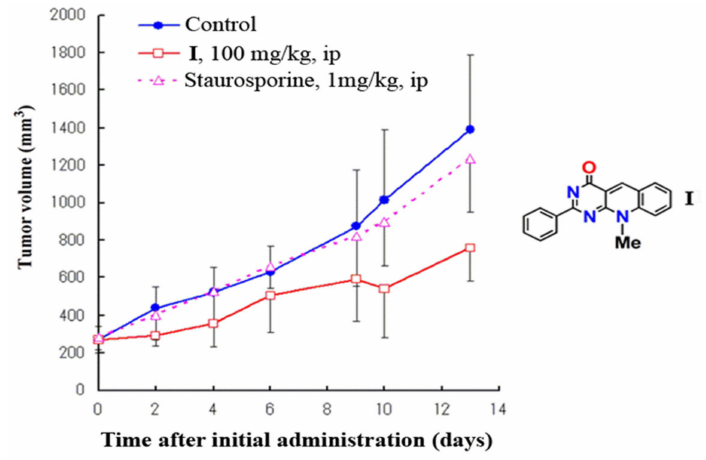
Figure 1. One hundred mg / kg, i.p., of compound I reduced the tumor volume of Subcutaneous (SC) implanted A431 into nude mouse 53.4% after 10 days of 100 mg / kg, ip.